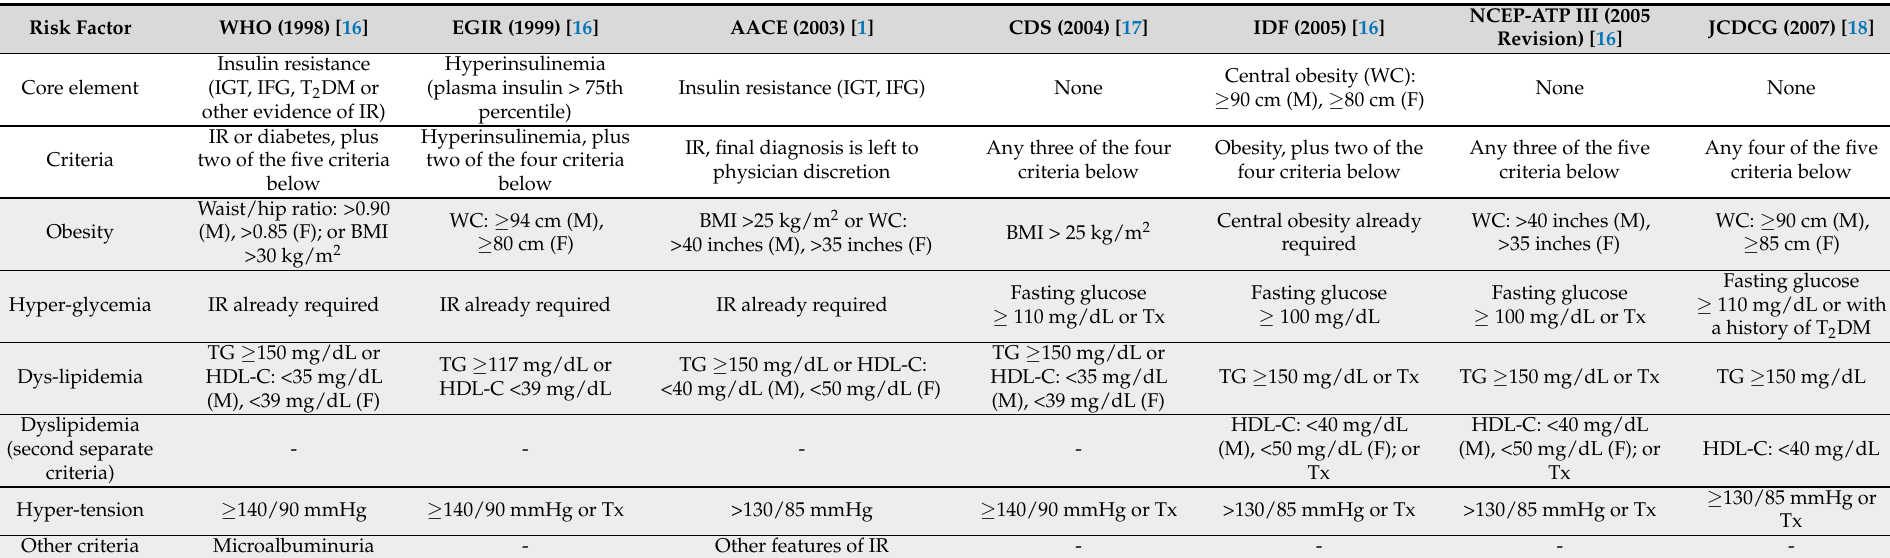
Table 1. Comparing criteria of metabolic syndrome of seven professional